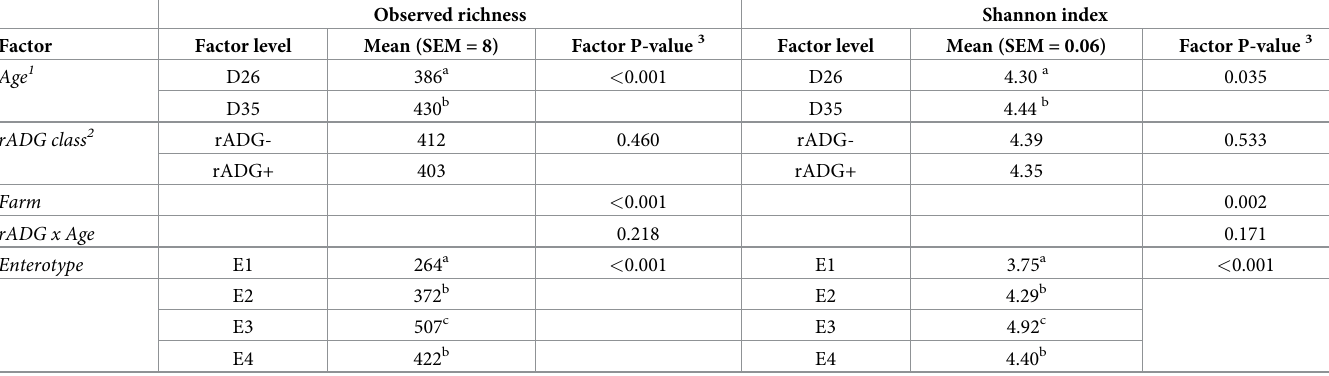
Table 2. Influence of age, relative average daily gain, and microbial enterotype on alpha diversity indexes of fecal